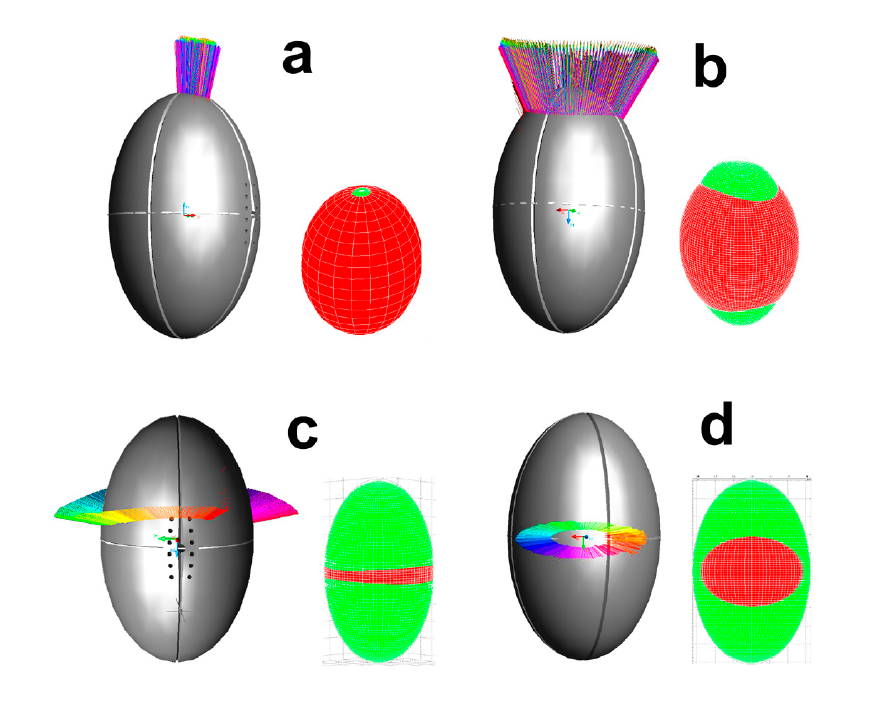
Figure 2. ω -vectors (colour-coded) projected on the surface of an AFL ball and the corresponding ellipsoids: ( a ) almost-perfect torpedo punt, the ball spins about the major axis of the ball and ω precesses about the major axis; ( b ) imperfect torpedo punt, the ball spins about the major axis and ω precesses about the major axis; ( c ) imperfect drop punt, the ball spins about the minor axis of the ball and ω precesses about the major axis; ( d ) almost-perfect drop punt, the ball spins about the minor axis of the ball and ω precesses about the minor